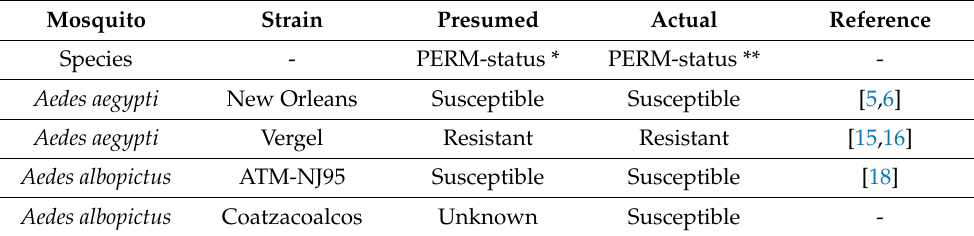
Table 1. Mosquito strains used to analyze permethrin resistance and reaction to Nootkatone. Mosquito Strain Presumed Actual Reference Species - PERM-status * PERM-status ** - Aedes aegypti New Orleans Susceptible Susceptible [5,6] Aedes aegypti Vergel Resistant Resistant [15,16] Aedes albopictus ATM-NJ95 Susceptible Susceptible [18] Aedes albopictus Coatzacoalcos Unknown